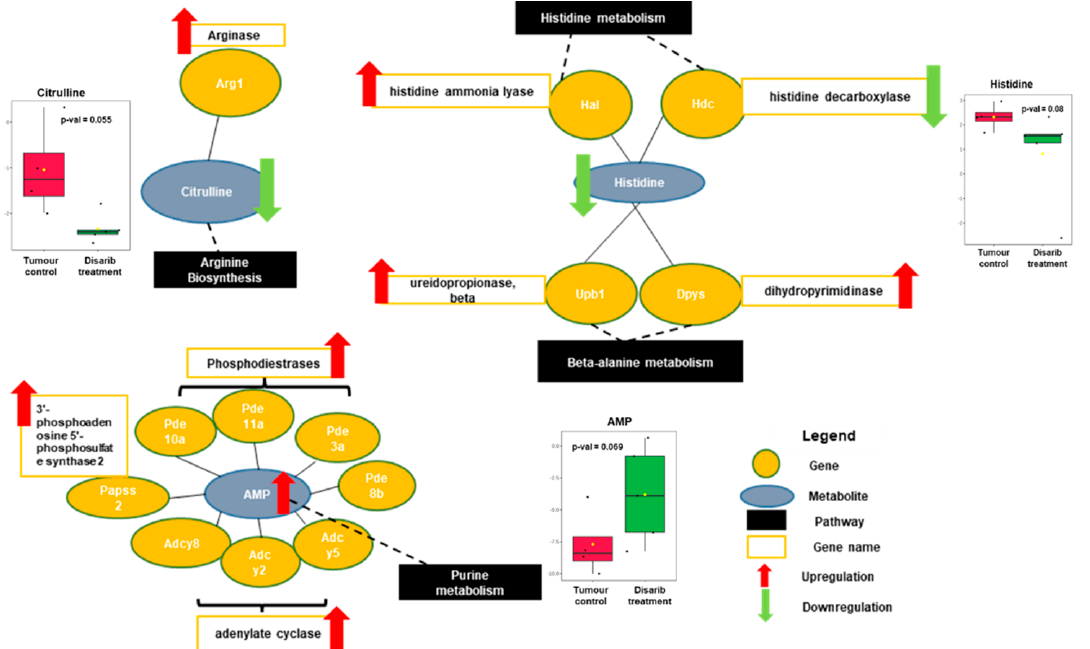
Figure 6. Interaction network between transcriptome and metabolomic data of Disarib treated EAC tumour samples. Significant DEGs and significant metabolites with VIP scores greater than 1 were utilized to generate the matched features using metaboanalyst. DEGs are represented in yellow circle, metabolites in grey and pathway in black rectangle. Red colour arrow denotes upregulation and green arrow denotes downregulation. Individual box plots with fold changes and p -value are plotted for citrulline, histidine and AMP metabolites where red colour denotes tumour control, and green colour denotes Disarib treated